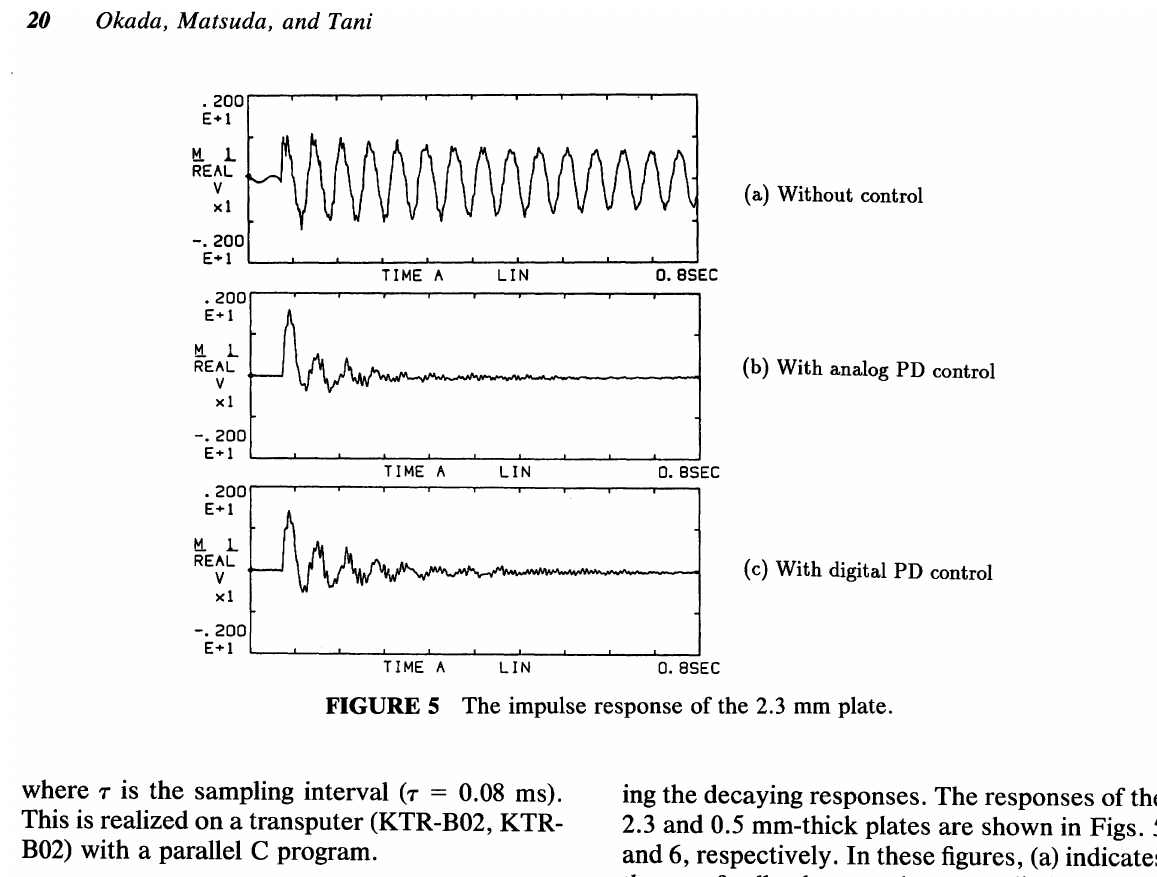
FIGURE 5 The impulse response of the 2.3 mm plate.